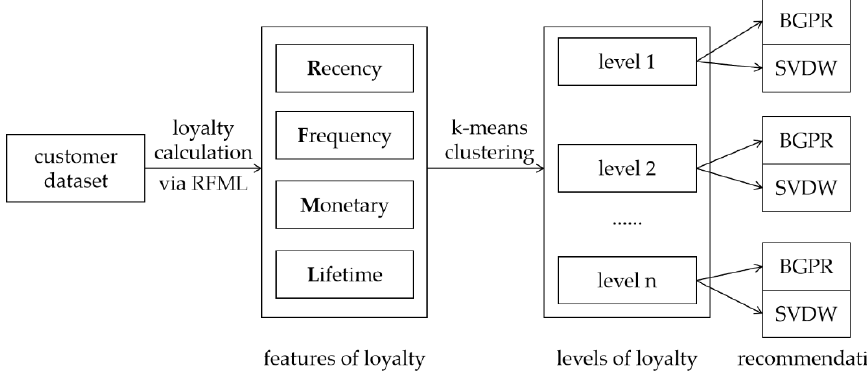
Figure 1. Overall framework of this study.